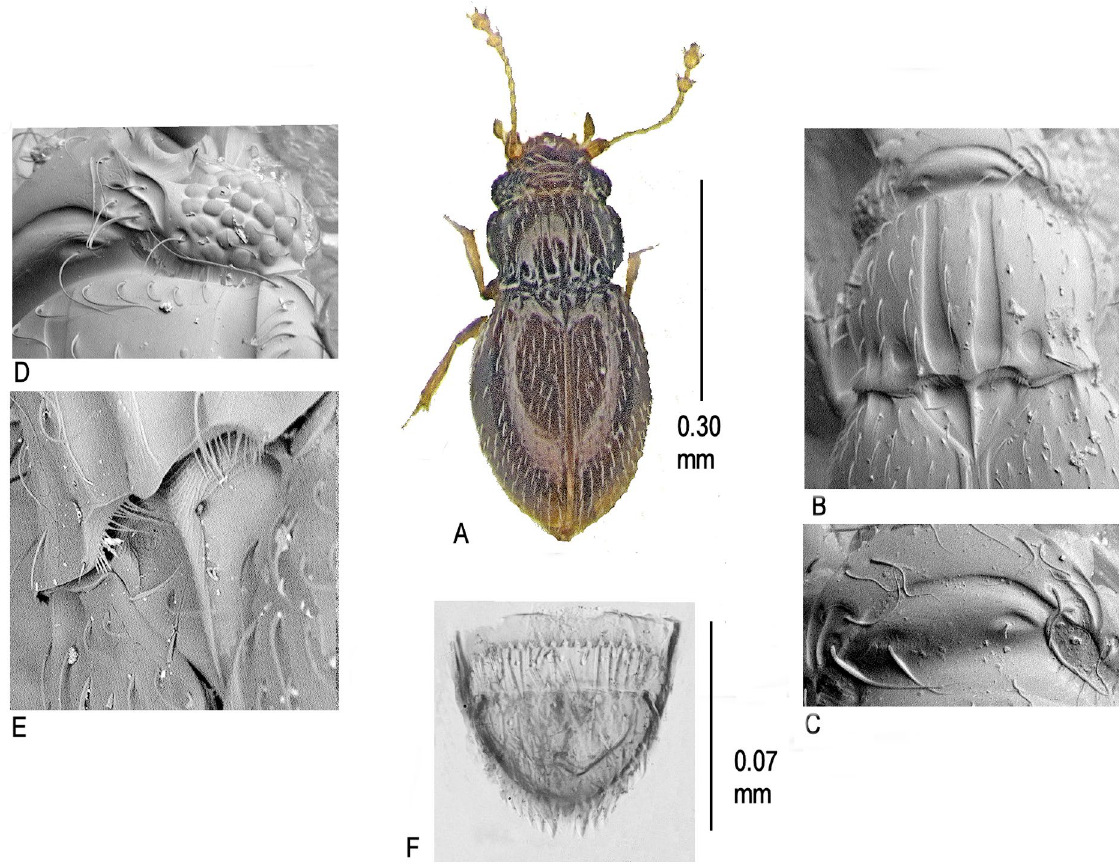
Fig. 10. Discheramocephalus nigritus sp. nov. A . Habitus. B . Pronotum ×625. C . Back of head ×600. D . Fovea behind eye ×1800. E . Scutellum ×1500. F .